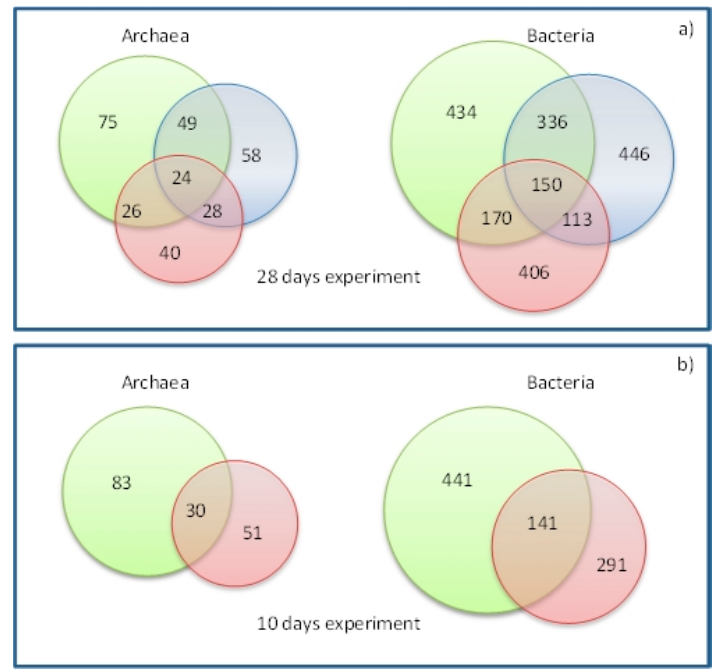
Figure 4. Venn diagrams representing the shared OTUs between samples from the batch tests after the different inoculum treatments, ( a ) 28-day experiment (days 7, 14, 21 and 28), and ( b ) 10-day experiment (days 1, 3, 6 and 10). Each set of samples is differentiated by the colors. Green color refers to the CR samples with BW and control inoculum, red color to TH samples with BW and inoculum thermal treatment, and blue color to FR samples with BW and inoculum freeze-thaw treatment.